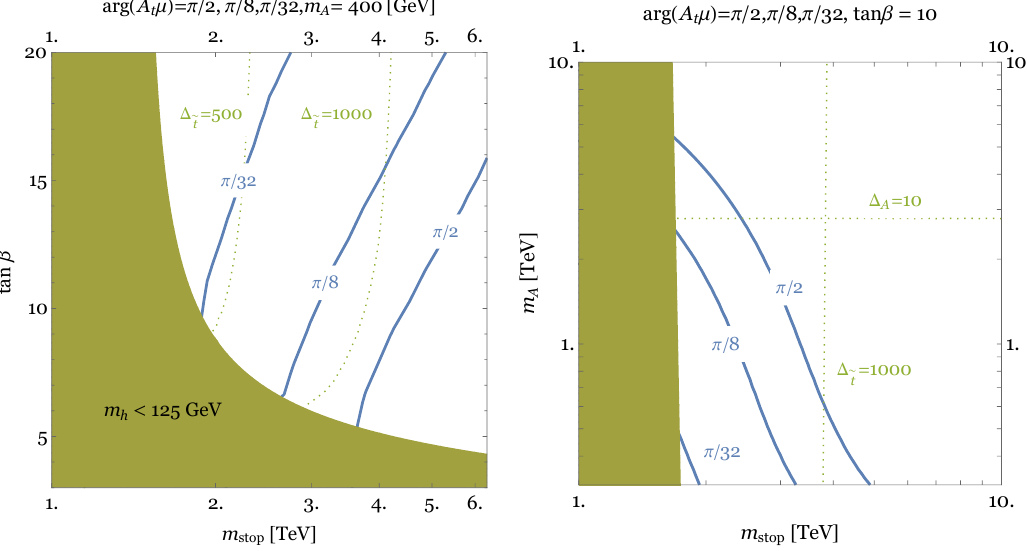
= m . The vertical axes show tan (cid:12) e Q 3 e u 3